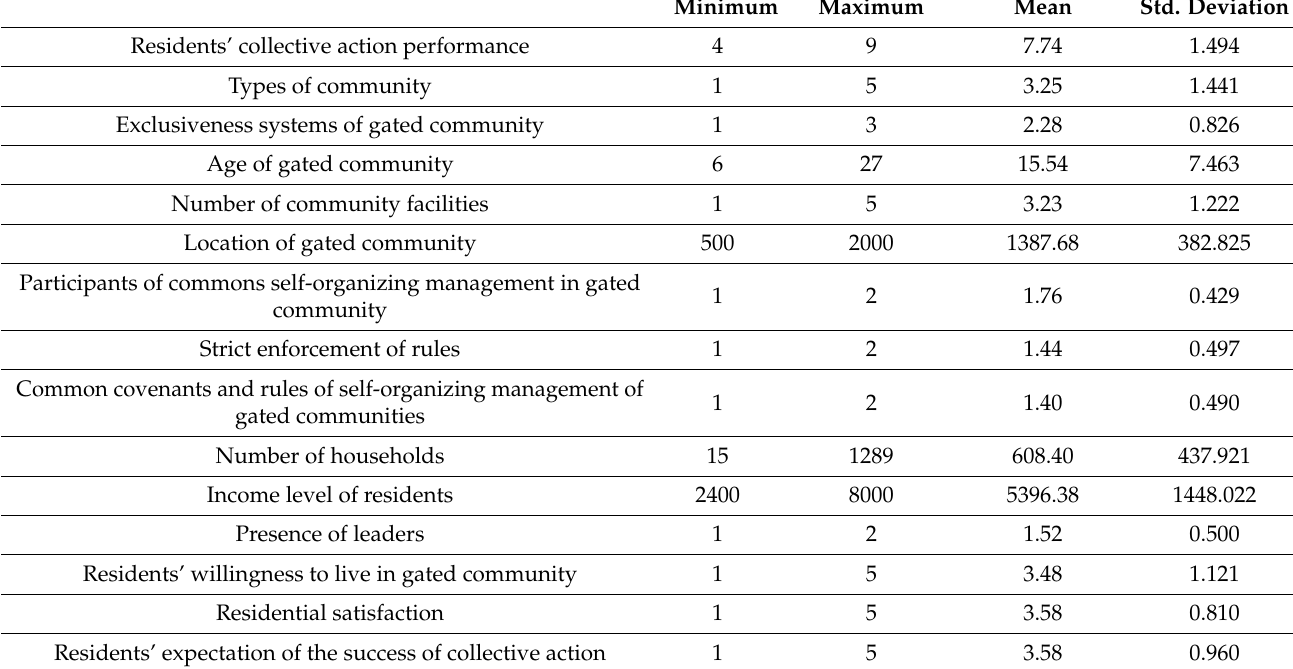
Table 7. Descriptive statistics of the variables (n =